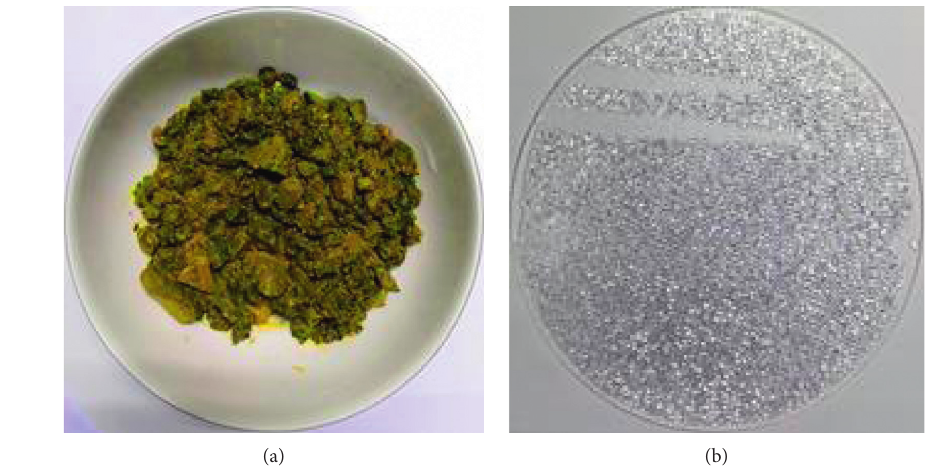
Figure 2: Evaporation of fluorescein in soil [26, 30, 31]. Table 1: Physical properties of